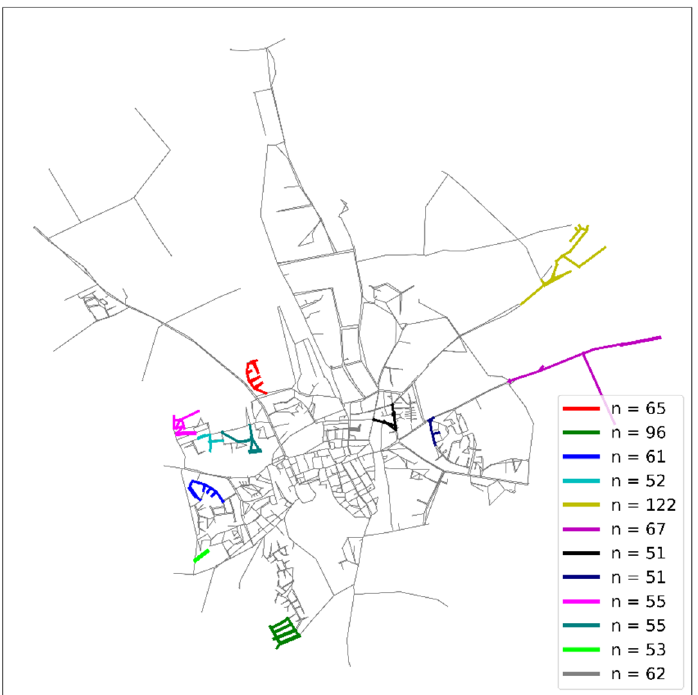
Figure 5. Sections with more than 50 connections in the optimized network design. Sections that do not meet the requirement even in the current design are marked with a color with a corresponding number of connections.